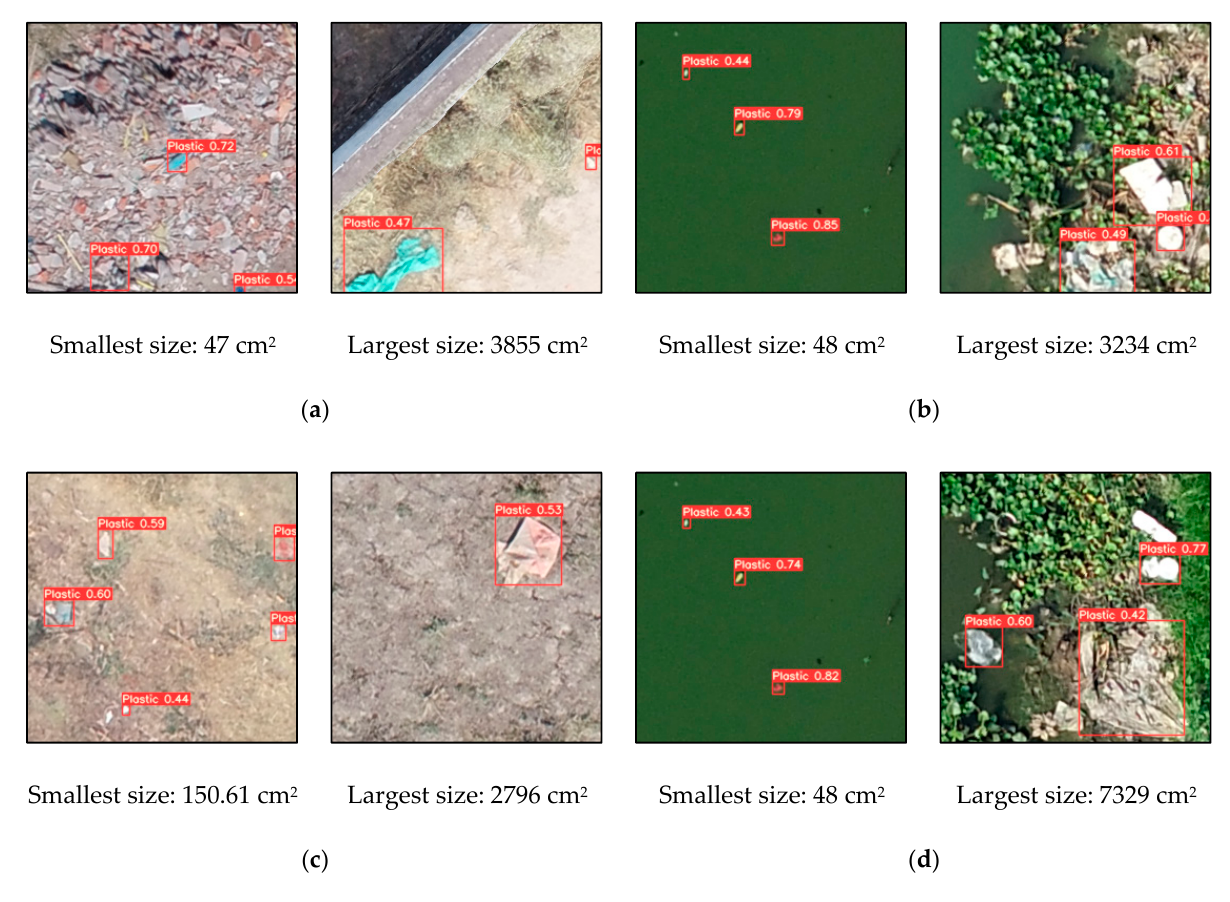
Figure 6. Experiment VII results. Smallest and largest plastics detected. ( a ) HMH. ( b ) TT. ( c ) Transfer from TT to HMH. ( d ) Transfer from HMH to TT. For reference, the actual dimensions of a 600 mL bottle of water are 23 × 5 cm = 75 cm 2 .